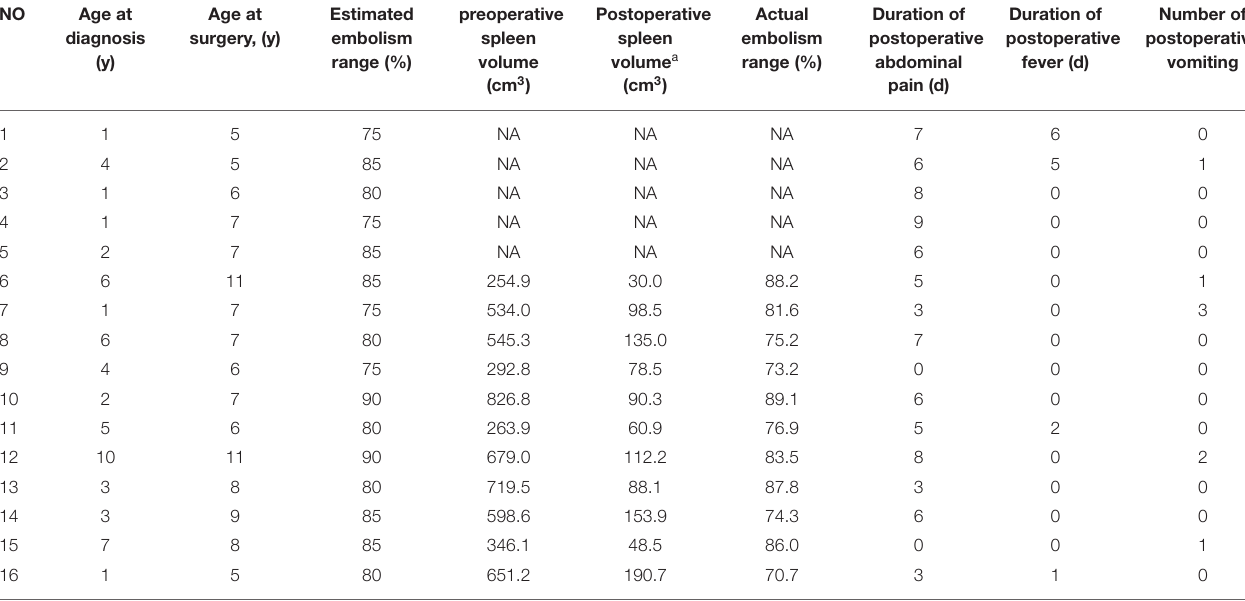
TABLE 2 | General conditions and surgical results in children with partial splenic artery